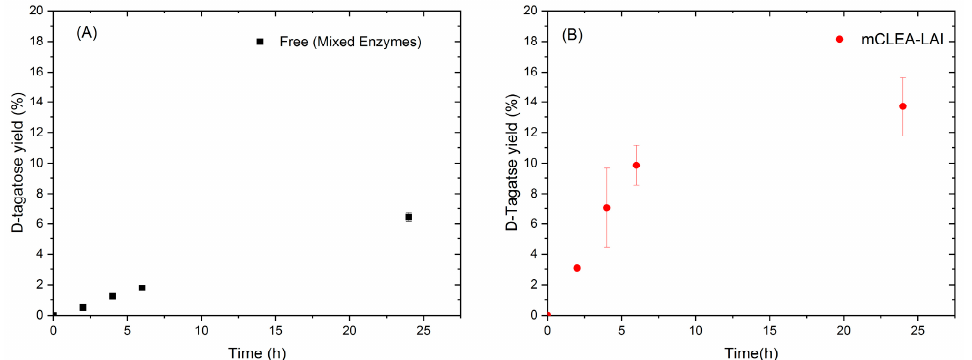
Figure 8. Bioconversion of lactose into D-tagatose, at pH 6.6: ( A ) simultaneous lactose hydrolysis and tagatose synthesis using free enzymes (mixed β -Gal + L-AI) at 50 ◦ C and pH 6.6 and ( B ) Sequential lactose hydrolysis (first bioreactor) catalysed by mCLEA-DEX at 37 ◦ C and pH 6.6 and galactose isomerisation 50 ◦ C (second bioreactor) catalysed by mCLEA-LAI.